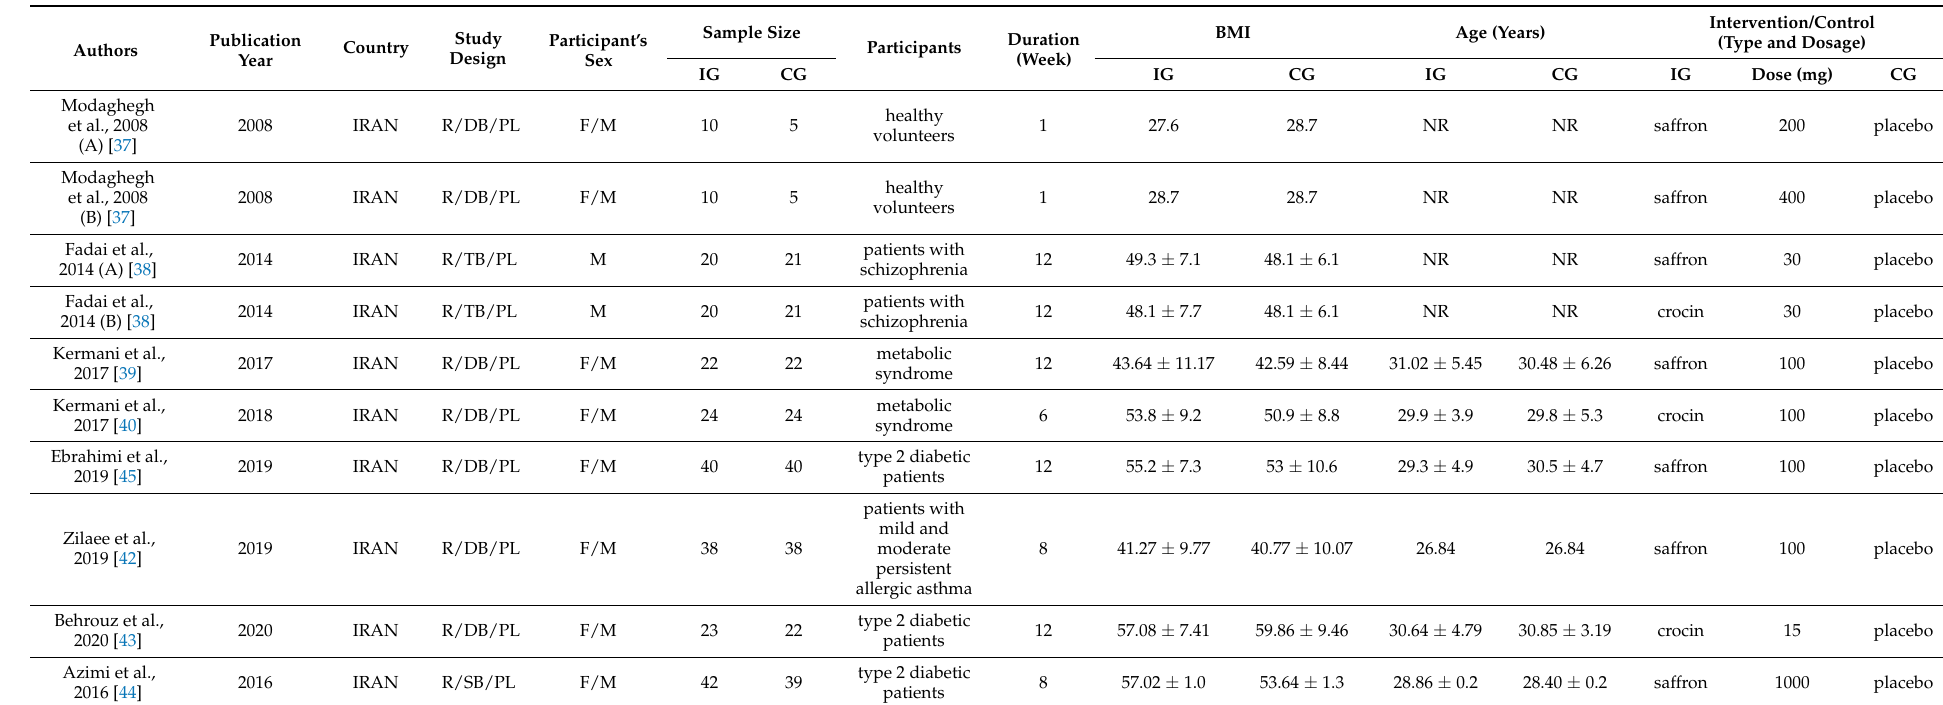
Table 1. Characteristics of included